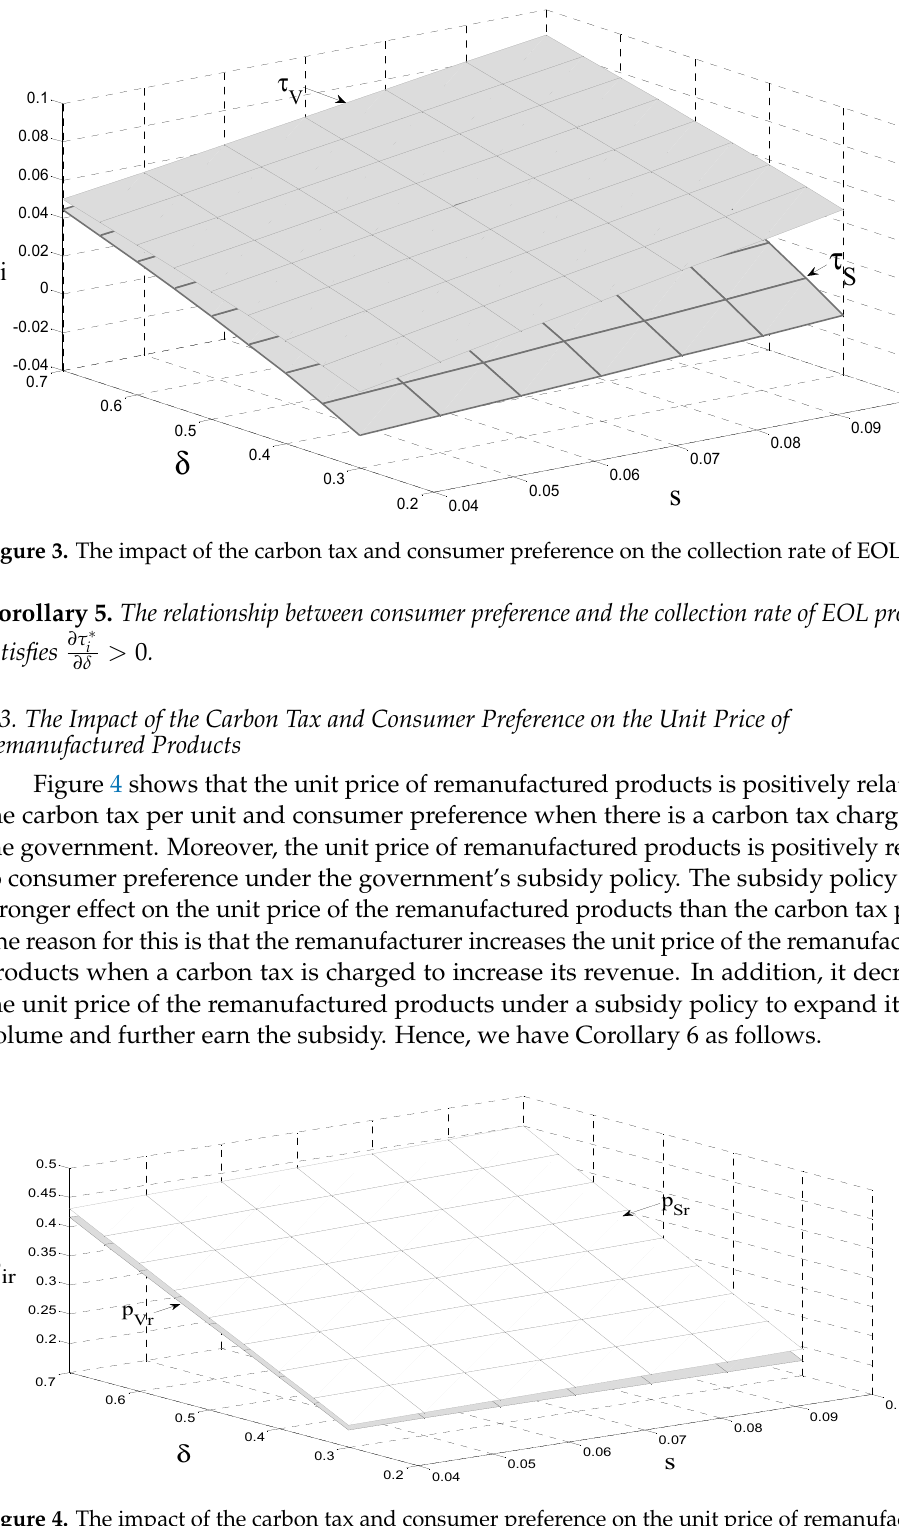
Figure 4. The impact of the carbon tax and consumer preference on the unit price of remanufactured products.